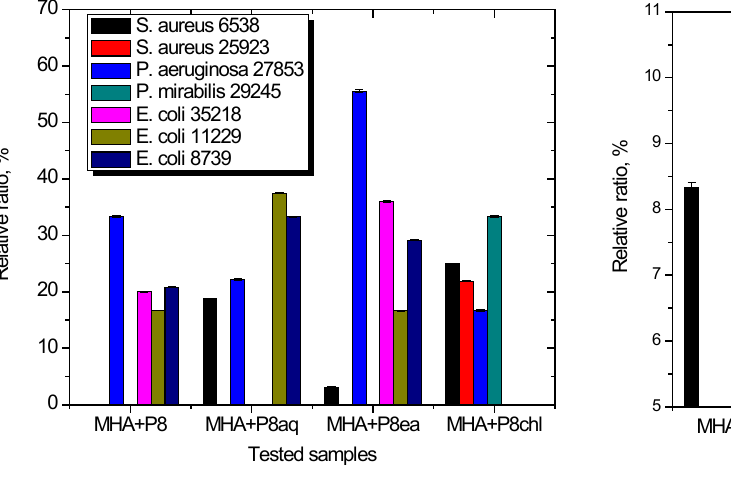
Figure 5: CN combinations.